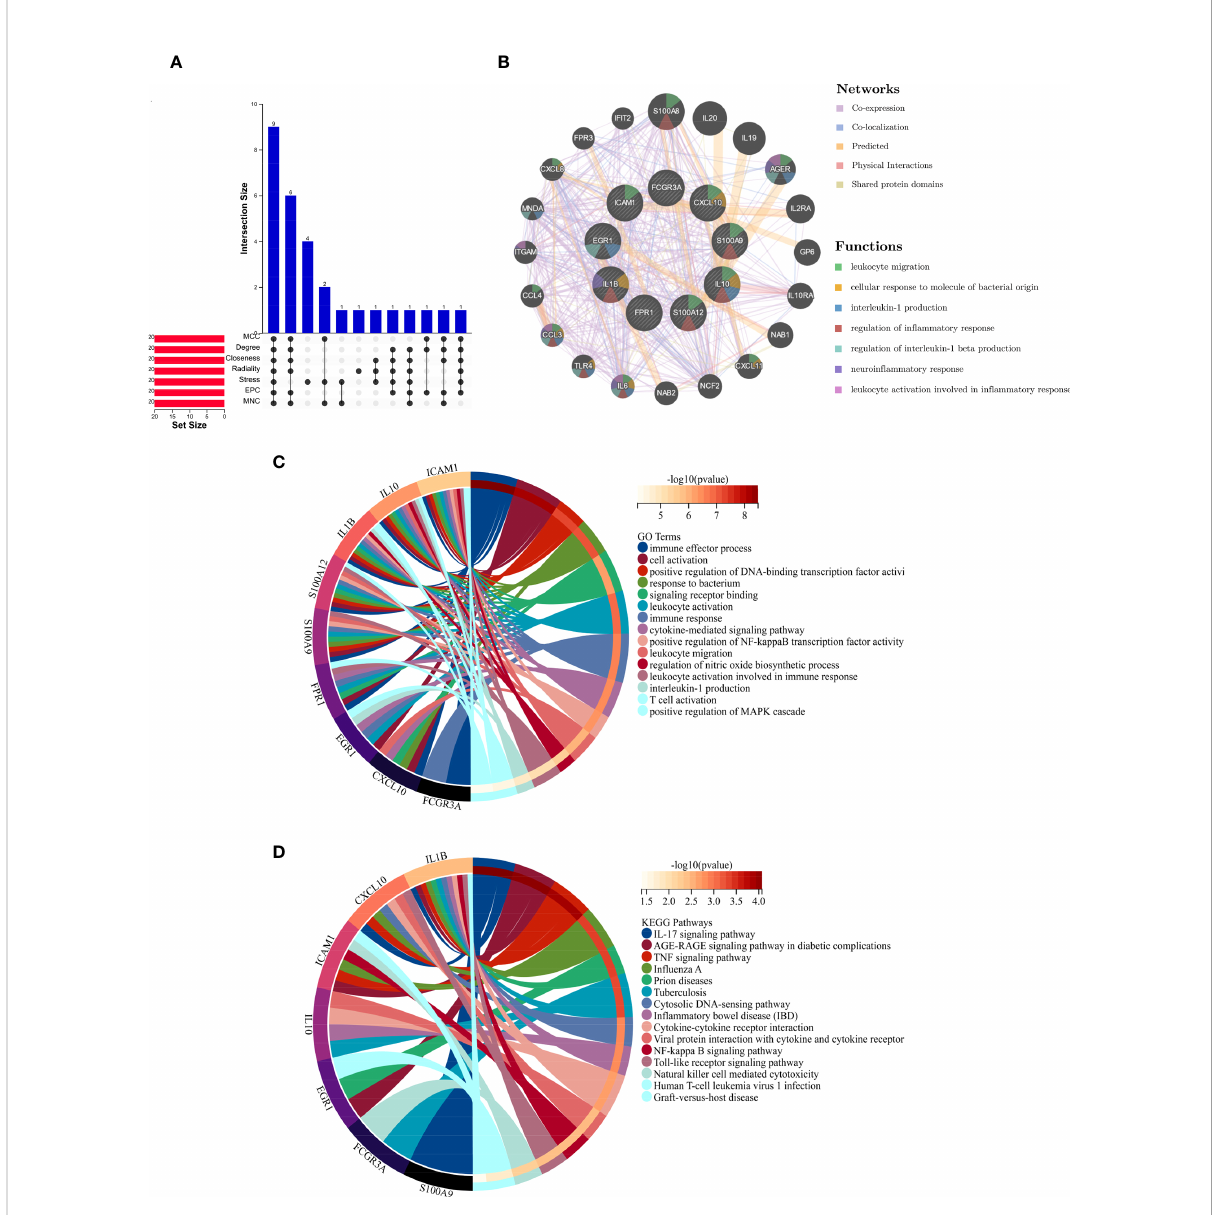
and the inner circle on the left represents the signi fi cant p-value of the corresponding pathway of the gene. GO, Gene Ontology; KEGG, Kyoto Encyclopedia of Genes and